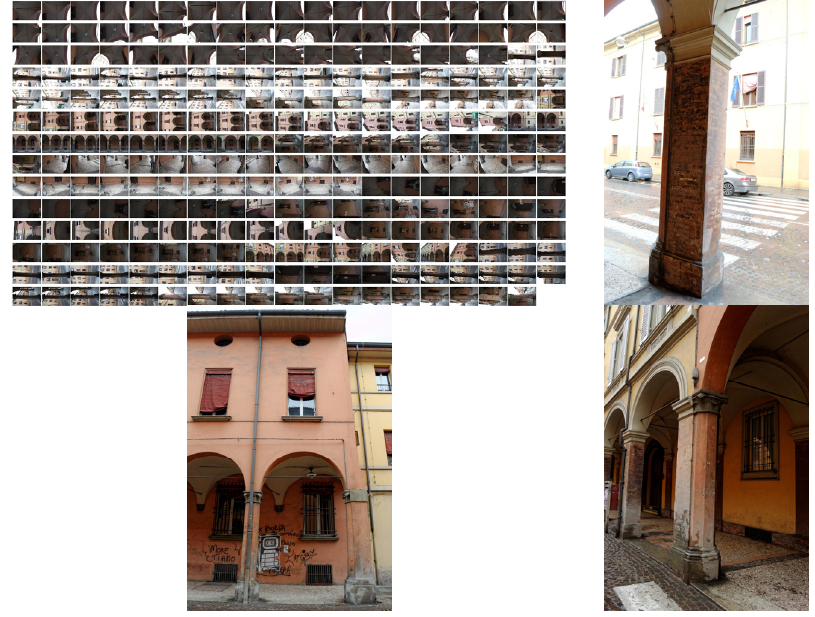
Figure 13. Dataset 3 (265 images)—a portico with arcades, columns, vaults and plastered walls. Table 7. Result of the image orientation on Datasets 3 (265 images) without or with various pre-processing methods.